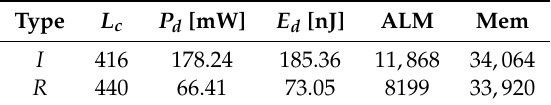
Table 3. Comparison of energy efficiency of decoders based on regular and irregular matrices for M × N = 512 × 1024, P = 64, Z = 3072 and f = 400 MHz.